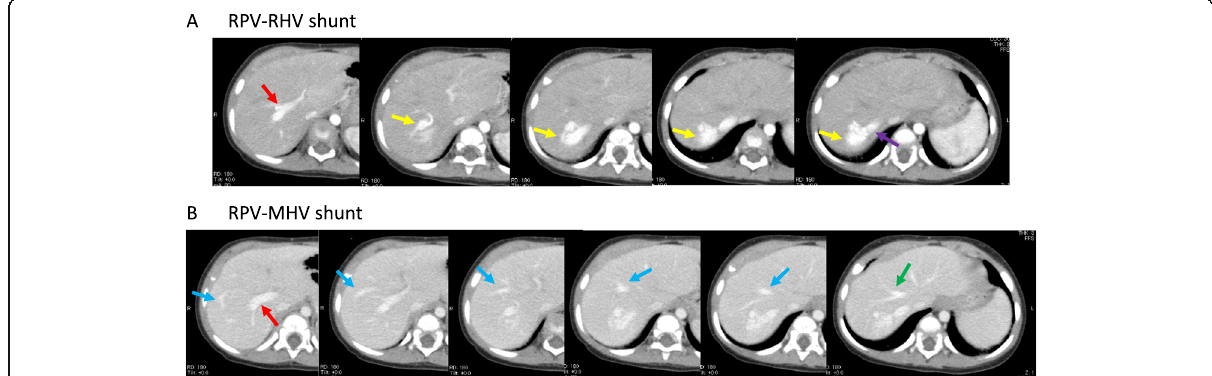
Fig. 2 Enhanced computed tomography at 1 year of age. a Enhanced computed tomography (CT) revealing a shunt vessel (yellow arrow) between the right portal vein (RPV) (red arrow) and right hepatic vein (RHV) (purple arrow). The shunt vessel (yellow arrow) presented a nidus-like form. b Enhanced CT revealing a shunt vessel (blue arrow) between the right portal vein (RPV) (red arrow) and the middle hepatic vein (MHV) (green arrow)